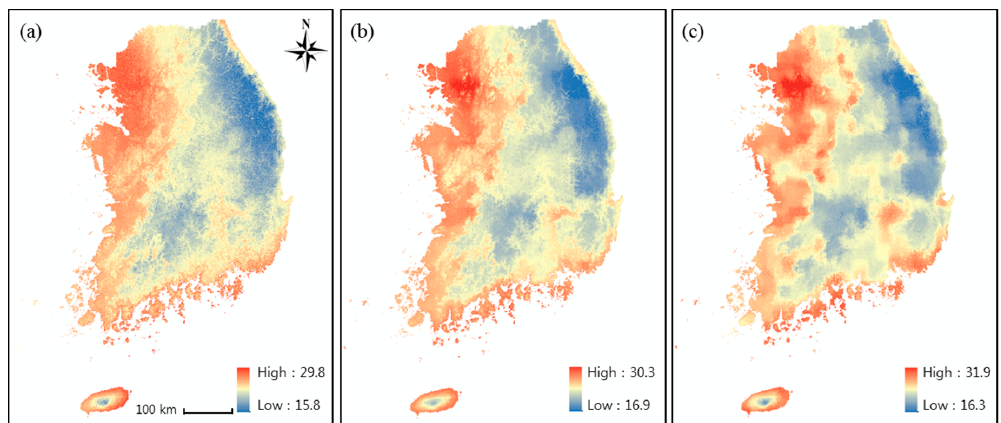
Figure 4. Daily maximum temperature on 1 August 2018, downscaled to a 1 km resolution: ( a ) SVM; ( b ) RF; and ( c ) GPRM. Units in the legend are degrees Celsius.